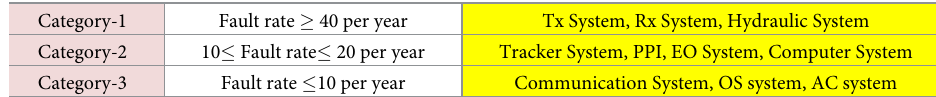
Table 4. Categorization of subsystems based upon annual fault